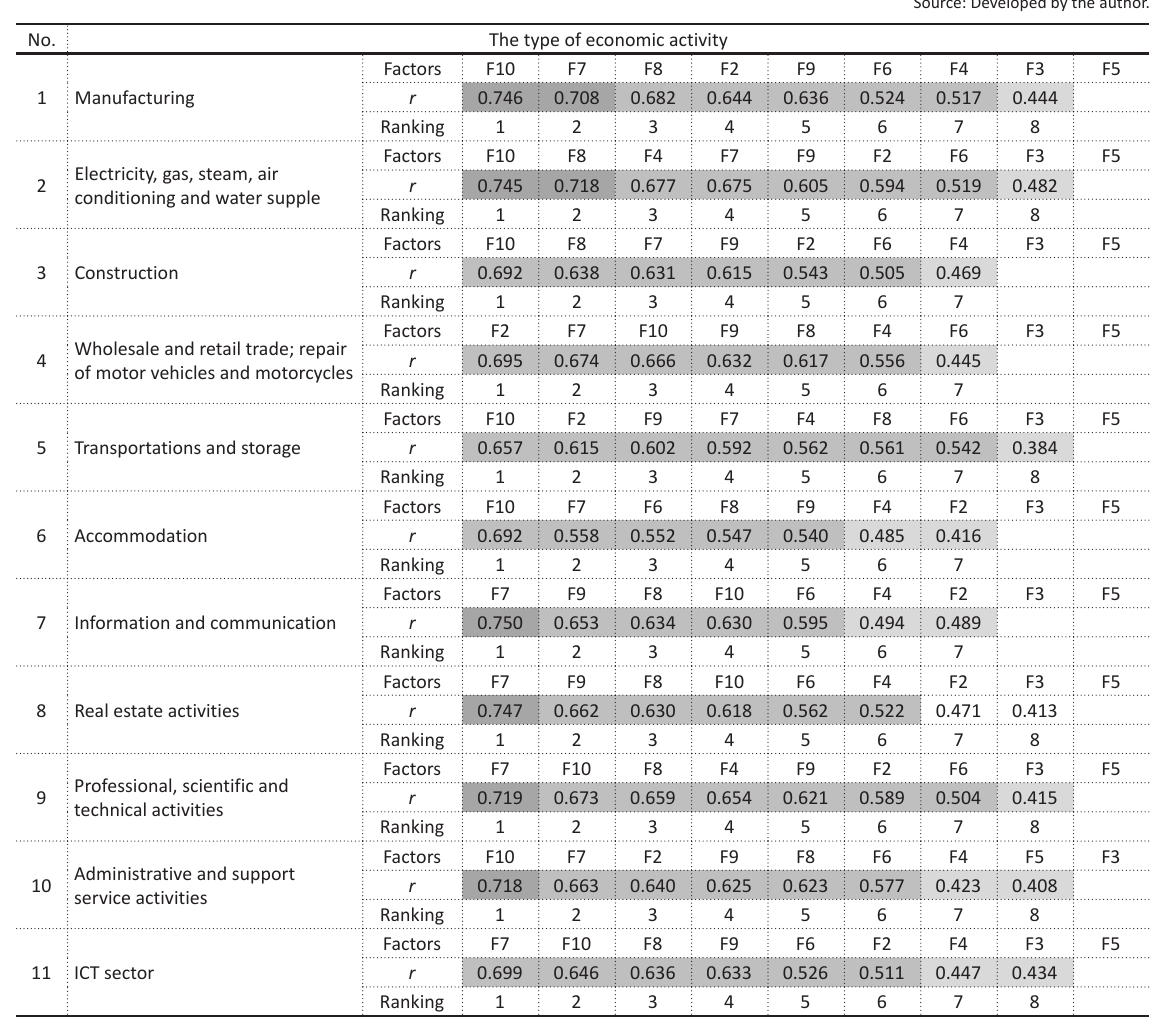
Table 4. Ranking of factors F2-F10 according to the type of business